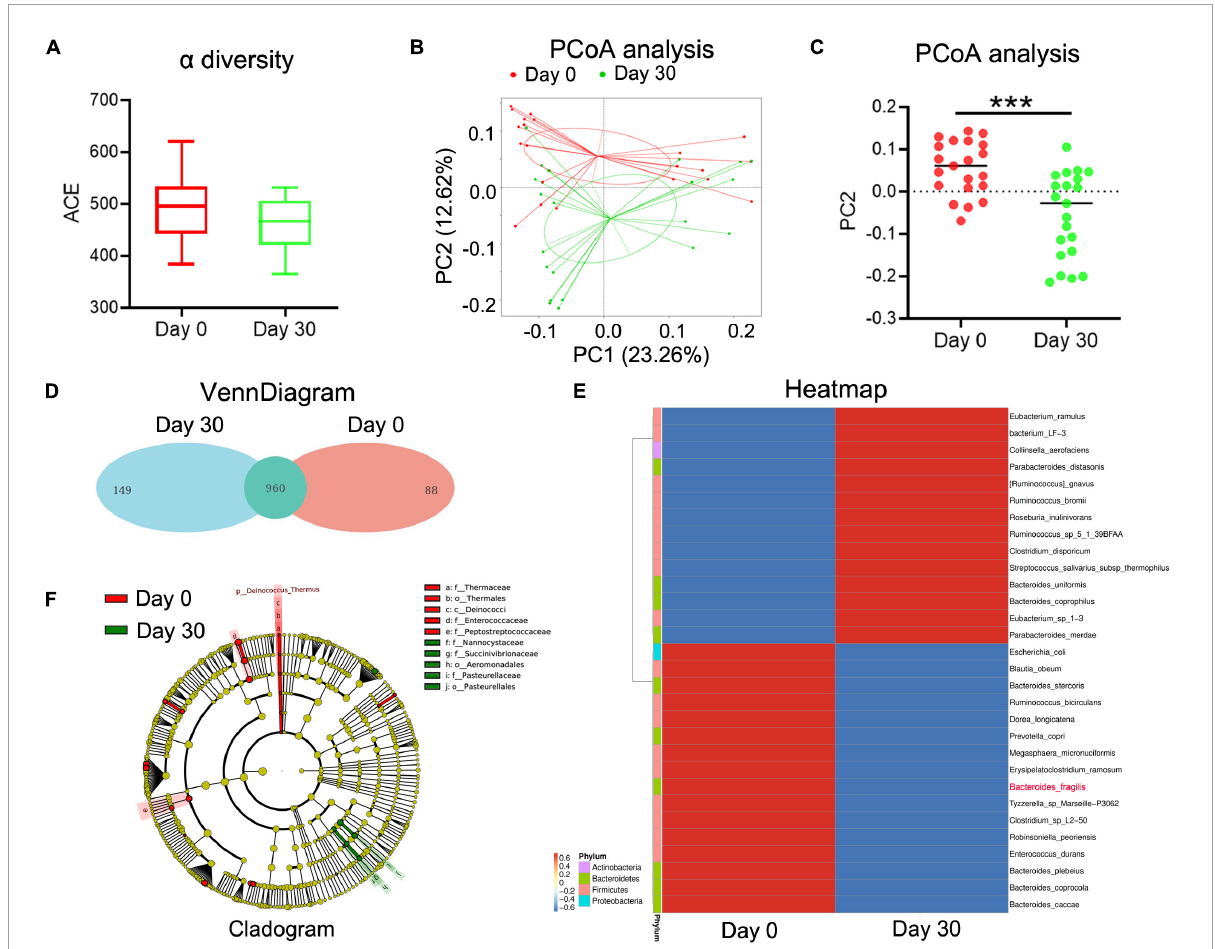
FIGURE1 The changes of gut microbiota in MTX-treatment patients. Stool samples were collected from 21 RA patients with MTX treatment at day 0 and day 30. Stool bacterial DNA was extracted using the Stool DNA Isolation Kit and detected using 16S rRNA amplicon sequencing. (A) ACE analysis to predict species richness among different groups. (B,C) PCoA to assess differences between microbial communities. (D) Flower figure of VennDiagram to show the common and unique OTUs among different groups. (E) Heatmap to present the change of different species. (F) Cladogram to analyze different species between groups. *** p <